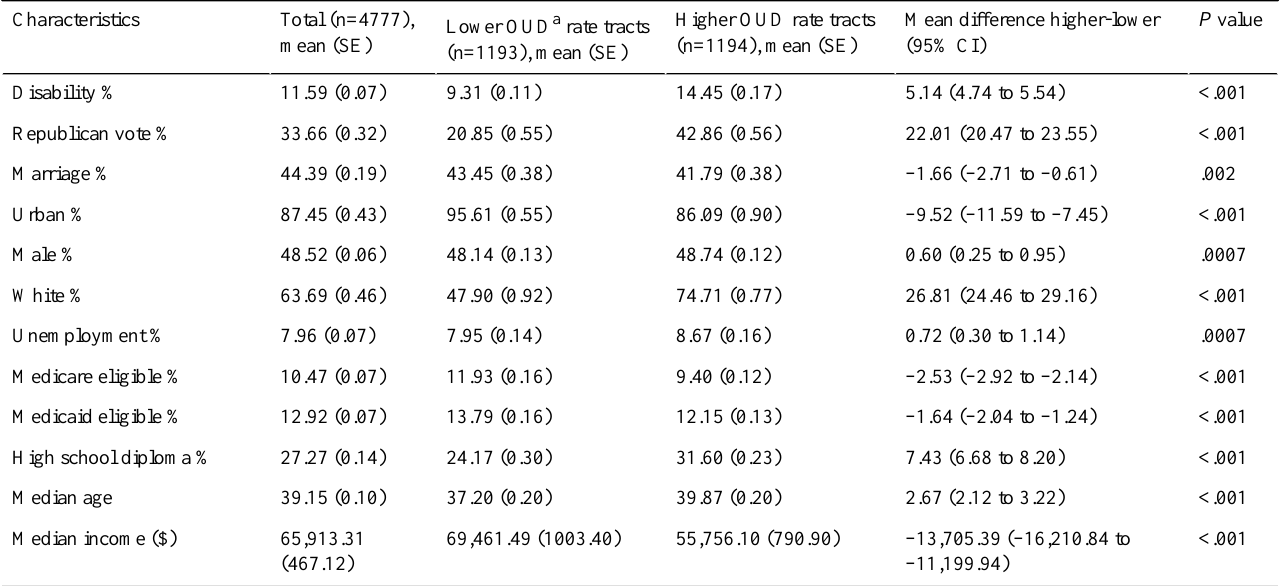
Table 2. Characteristics compared between census tracts with lower opioid use versus census tracts with higher opioid use in New York State, 2010-2016.